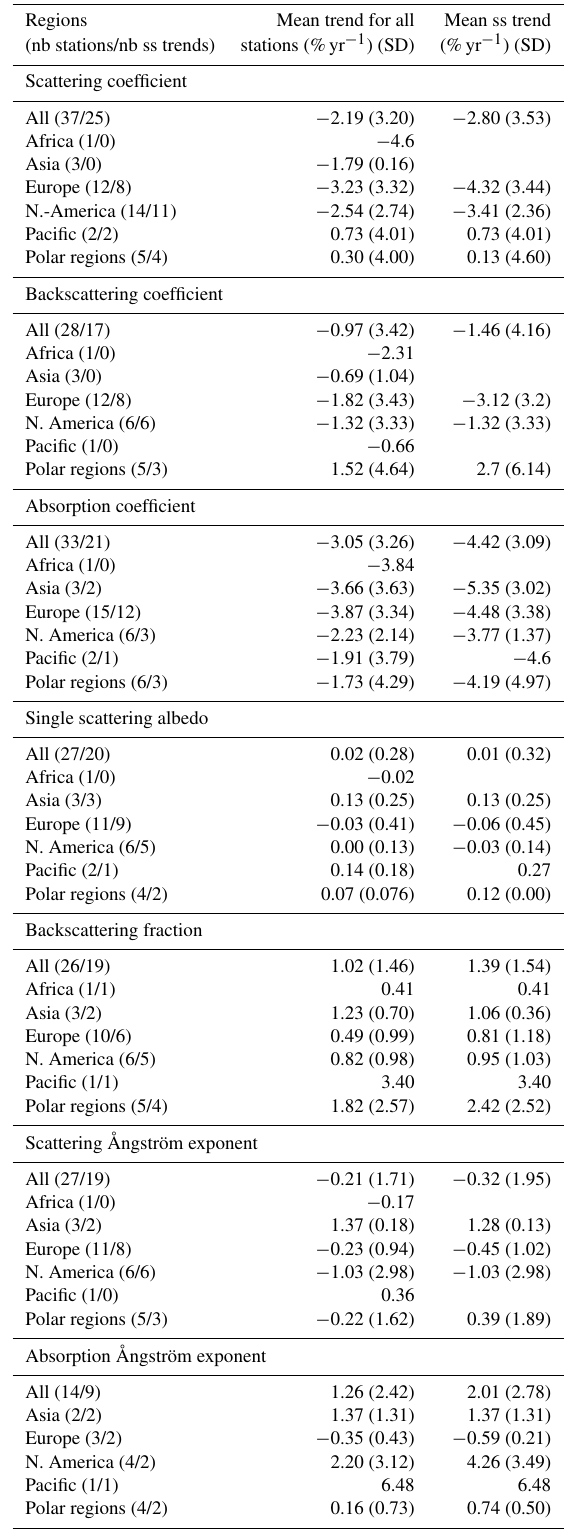
Table 4. Overview of the aerosol optical property decadal MK trends ending between 2016 and 2018 for all the stations and per continent/region of the